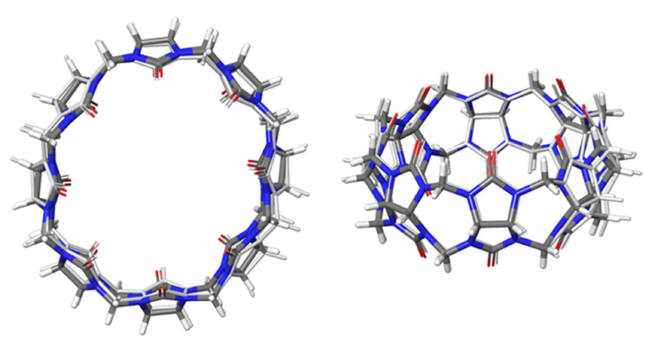
Figure 3. Structural superposition of the experimental X-ray structure of the CB[8] receptor (in color) and the GFN2-xTB-optimized structure. Left: Top view; Right: Side